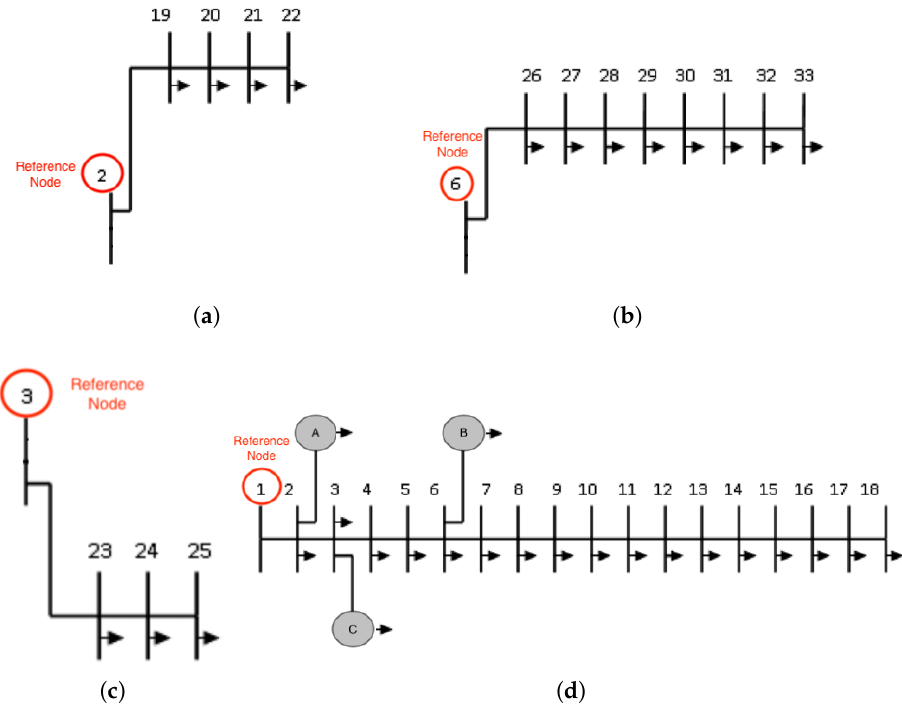
Figure 4. Sub-grid topology decomposition. Reference nodes of each sub-grid are circled in red. Sub-grids ( a – c ) are connected to the grey circles of sub-grid ( d ) whose reference node is bus 1.